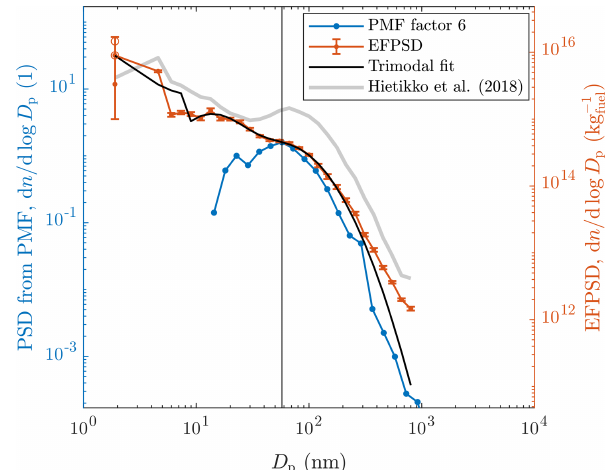
Figure 1. PSD from PMF factor 6 and EFs measured at Mäkelänkatu as PSD (EFPSD) together with the trimodal fit on it. The vertical line at 57nm denotes the highest D p considered in the updating process and is also the size where the PSDs overlap. The shape of the difference PSD measured at Mäkelänkatu (Hietikko et al., 2018) is also shown for comparison (the data are scaled so that they can be easily compared with the EFPSD